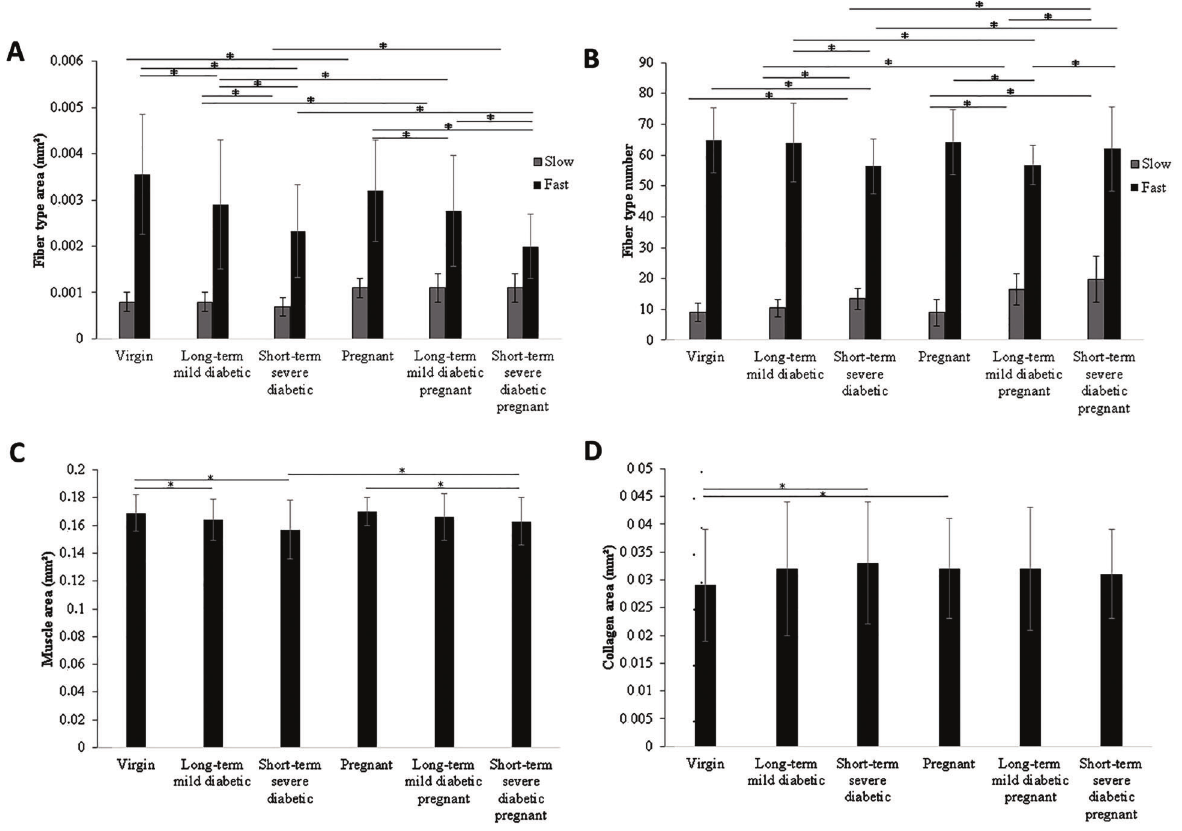
Figure 5. Comparison of fi ber type area ( t -test) ( A ), fi ber type number (Poisson test) ( B ), muscle area ( t -test) ( C ), and collagen area ( t -test) ( D) . Data are reported as means ± SD. *P o